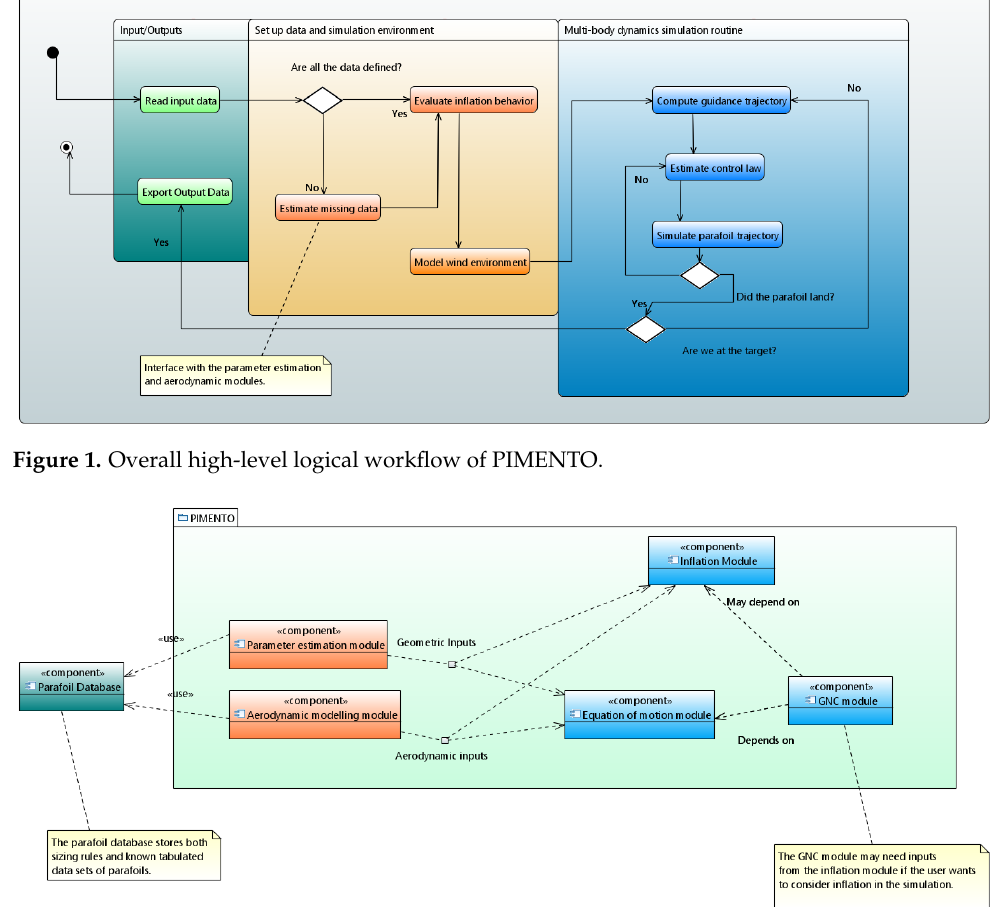
Figure 2. Overview of PIMENTO software